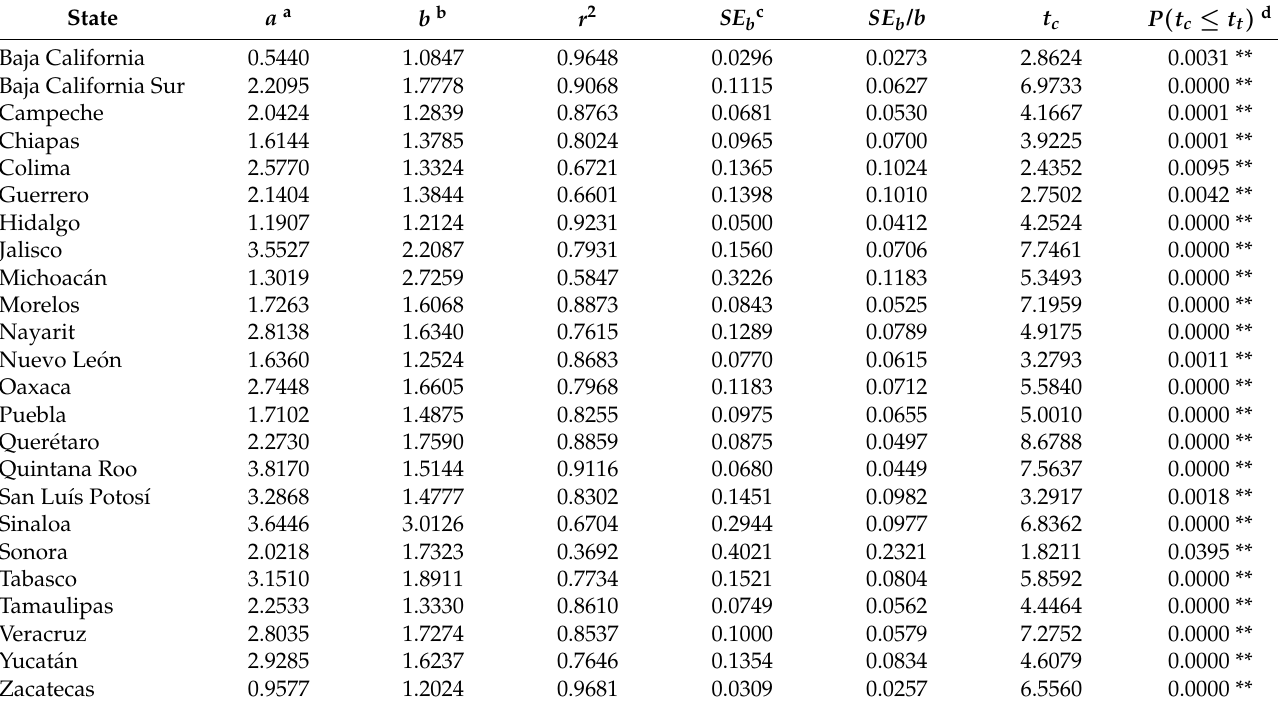
Table 2. Parameters of Taylor’s power law and hypothesis test H 0 : b 1 ≤ 1 using Student’s t -test in the 24 citrus producing states of